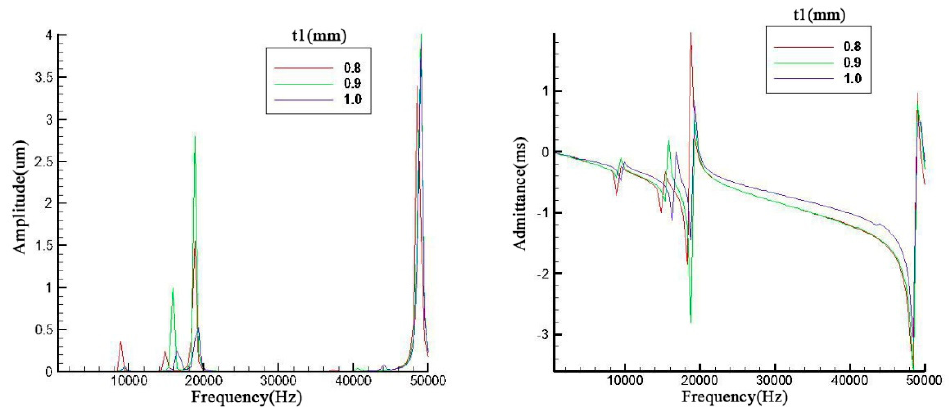
Figure 7. Simulation results with more analysis points.